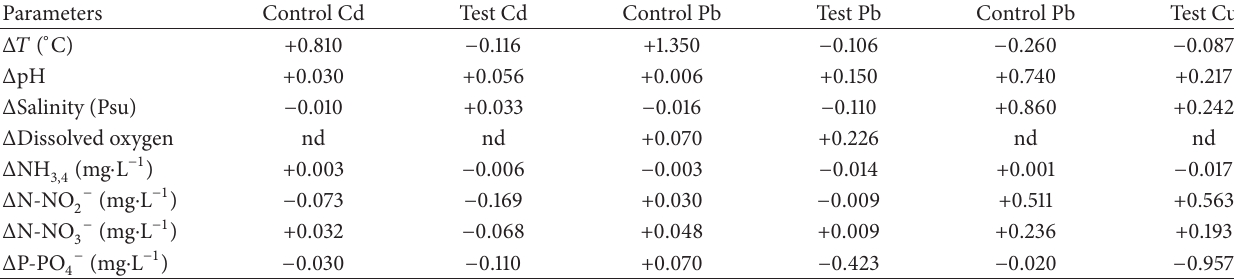
Table 1: Means of some physicochemical properties of the aqueous medium before and after the renewal. (+): augmentation, ( − ): diminishment.